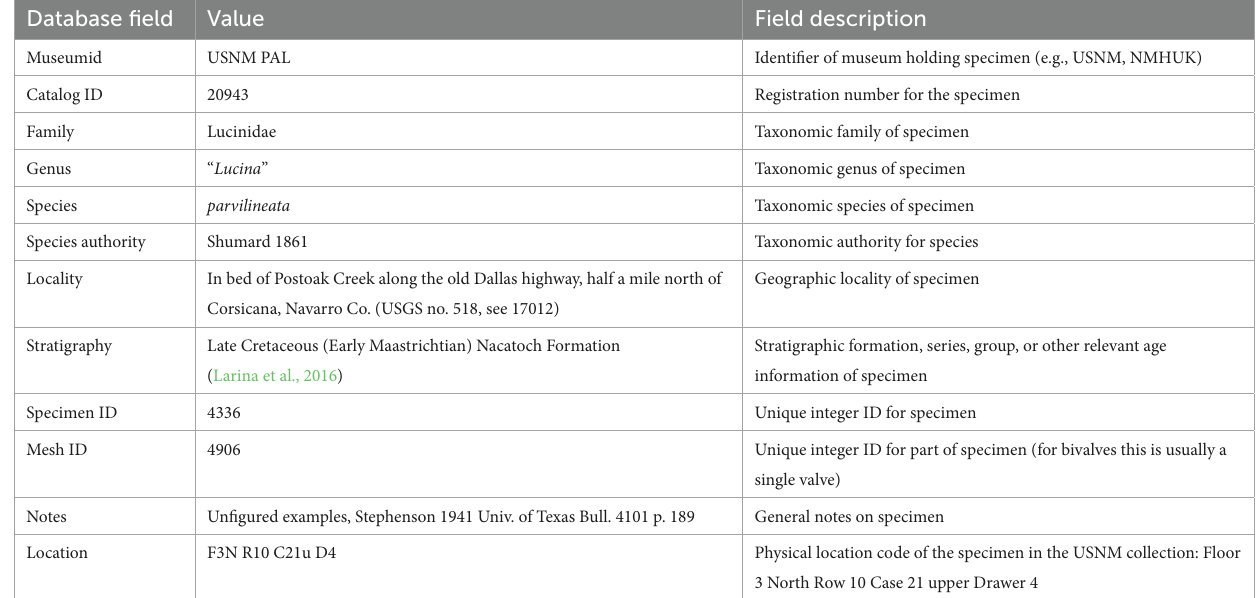
TABLE 1 Database schema for recording specimen